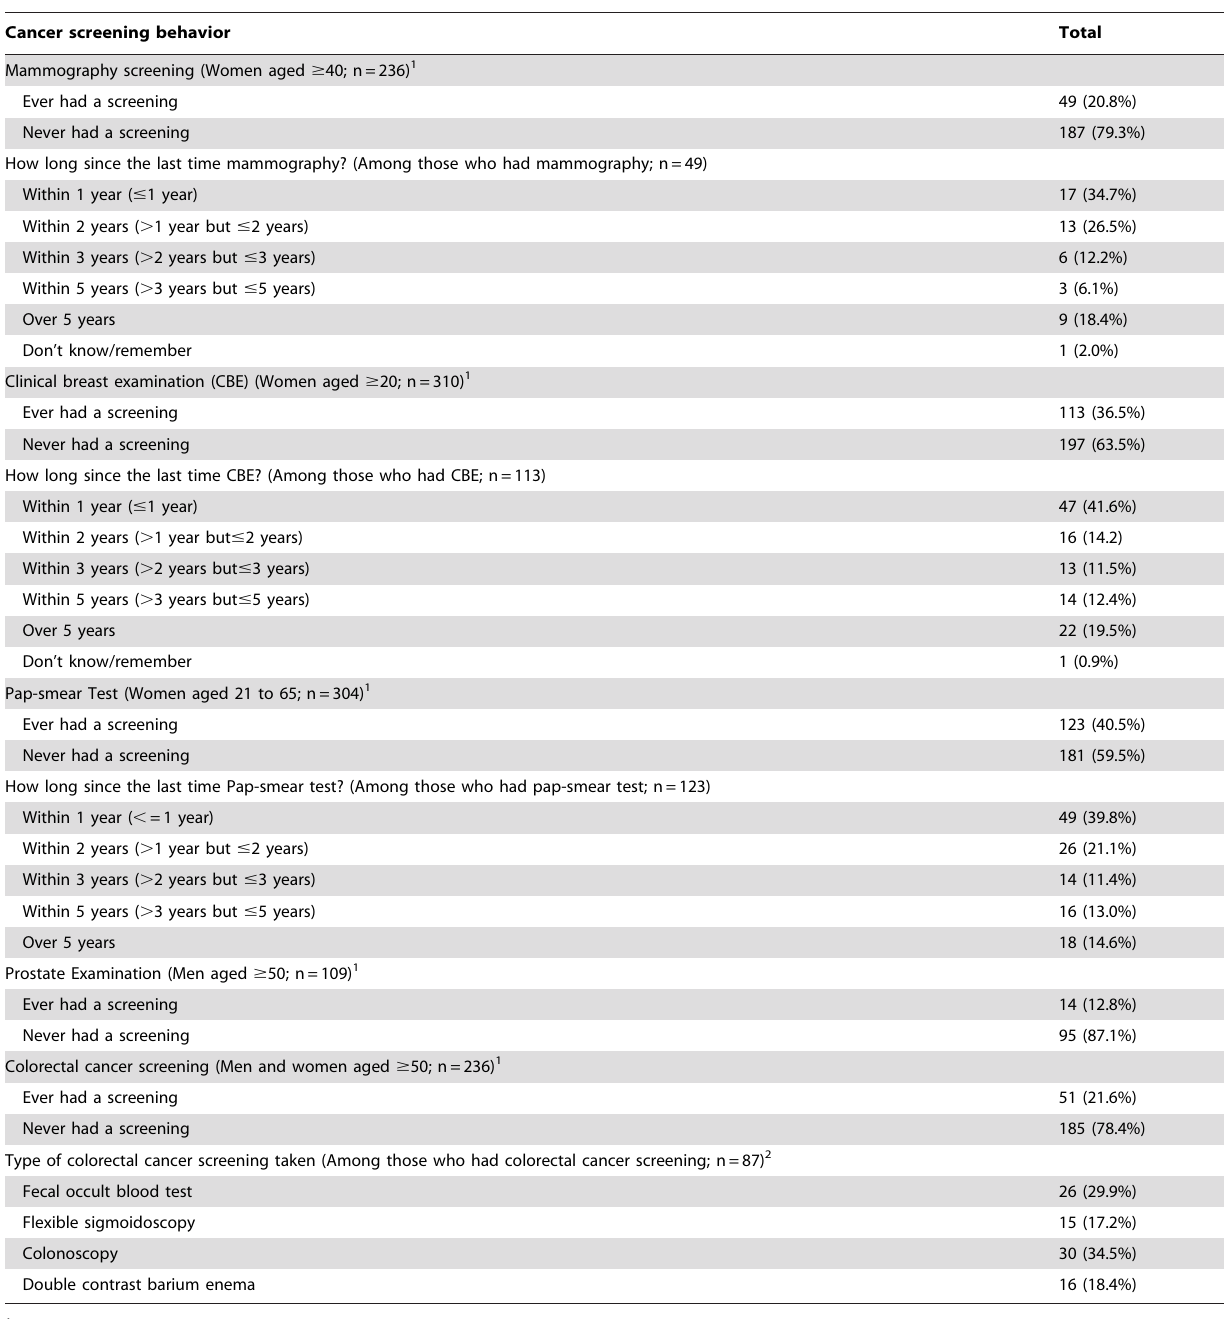
Table 2. Cancer Screening Behavior among People with Severe Mental Illness.